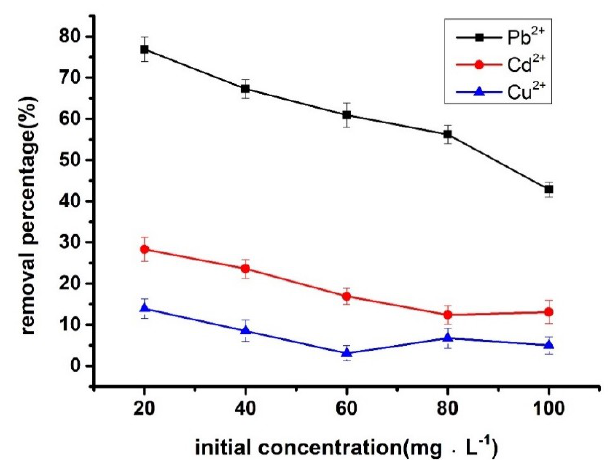
Figure 7. Competitive adsorption of Pb 2+ , Cd 2+ , and Cu 2+ on the adsorbents at a heavy metal ions concentration of 100 mg·L −1 , each adsorbent dose of 12.5 g·L −1 , agitation speed of 150 rpm, temperature of 30 °C, and contact time of 24 h.